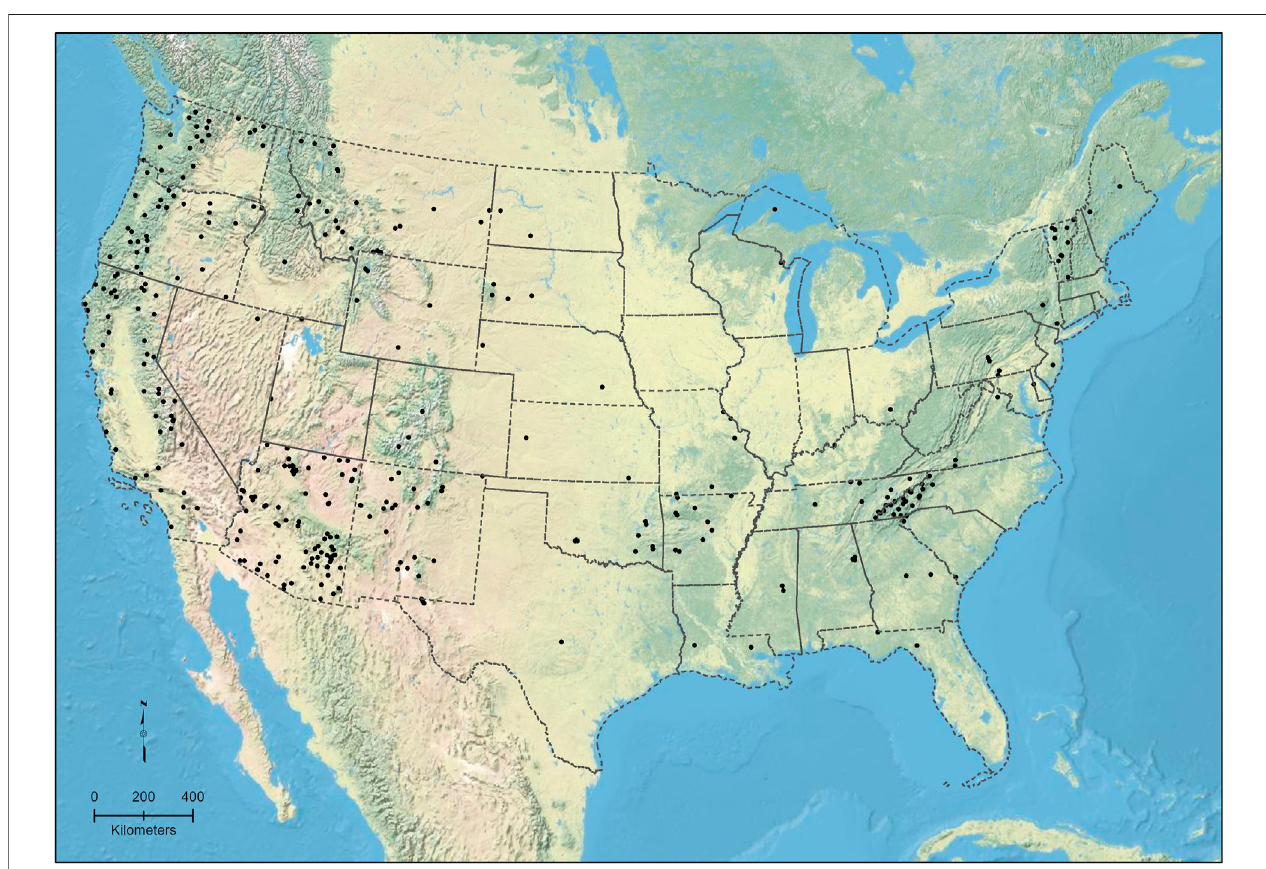
FIGURE 3 | Distribution of spot elevations analyzed in the study.